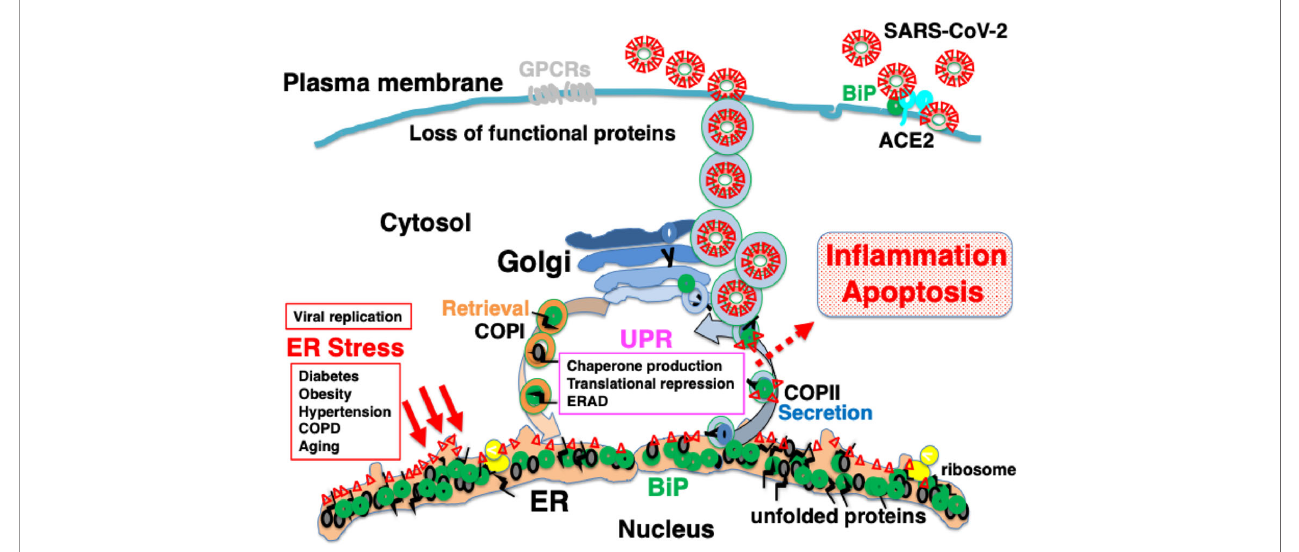
FIGURE 5 | Explosive SARS-CoV-2 replication may induce persistent ER stress, leading to in fl ammation and apoptosis. The extremely rapid rate of replication of SARS-CoV-2 increases ER stress to levels that cannot be accommodated by the UPR, leading to in fl ammation and apoptosis. Patients with comorbidities may have limited capacity for proteostasis, and be sensitive to ER stress caused by viral protein overload. Pharmacological chaperones may reduce ER